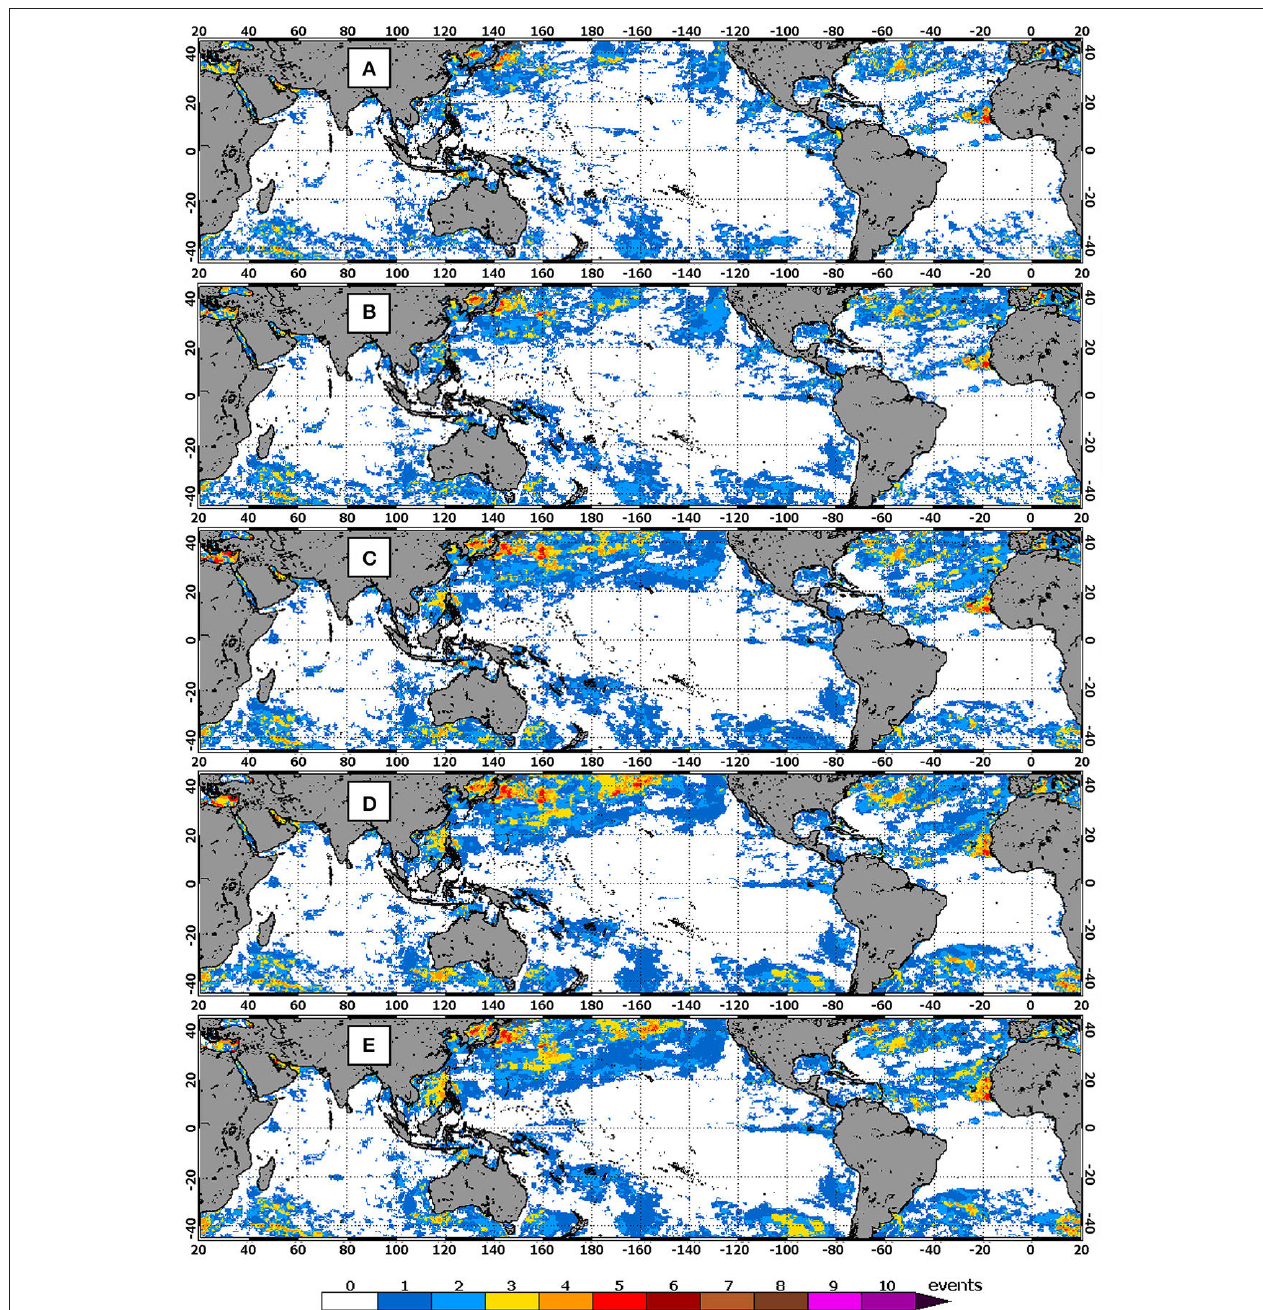
FIGURE 7 | Numbers of misses by CRW’s weekly Outlooks (Version 3) of 60% probability during the comparison time period of August 1, 2011–December 27, 2015 for lead-times of: (A) 3-weeks, (B) 5-weeks, (C) 9-weeks, (D) 13-weeks, and (E)